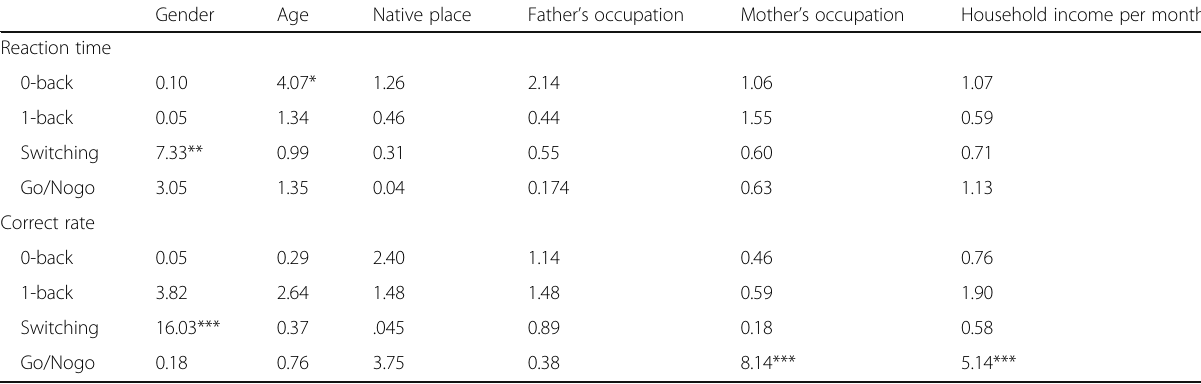
Table 3 The one-way ANOVA of demographic variables and EF